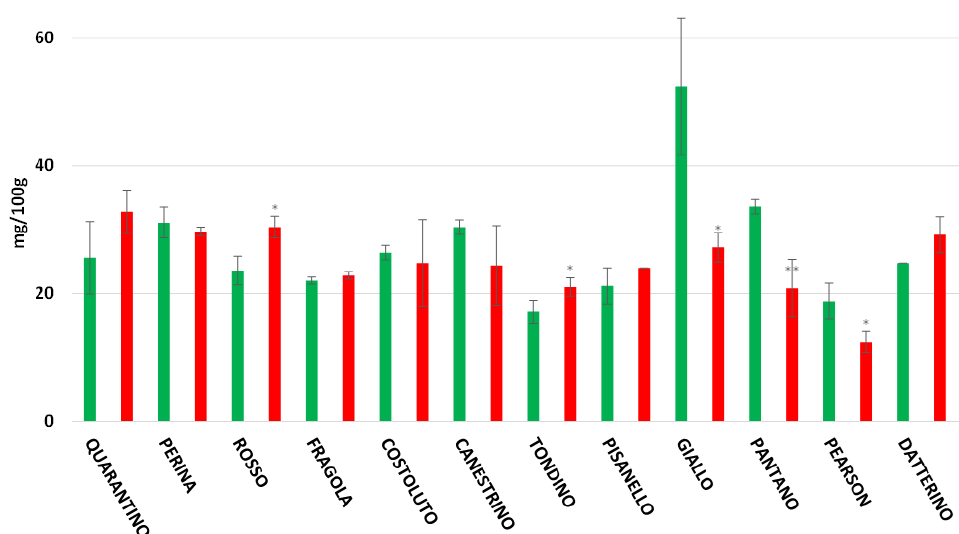
Figure 10. Vitamin C (ascorbic acid) content in tomato pulp of 9 Italian cultivars and three commercial cultivars. Controls (CTRL) in green and drought-stressed group (DS) in red. The bars indicate the standard deviation. A significantly difference is shown between CTRL and DS of each cultivar by * for a p ≤ 0.05 and ** for p ≤ 0.01.